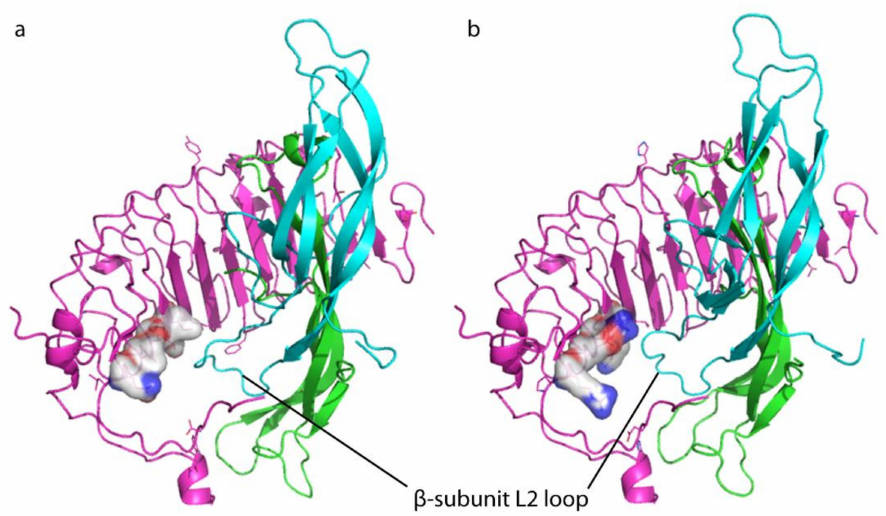
Figure 4. Comparison between mouse and human receptor extracellular leucine-rich-repeat domain (LRRD) bound to the heterodimeric hormone ( α and β subunit). ( a ) Images were obtained using hCG sequence as a template for the hormone, as previously described [3], and the α and β subunits are indicated with the colors green and light blue, respectively. Receptor LRRD is pink, while the murine and human LRR11 residue at positions 247, as well as the adjacent residues at position 225 and 270, are indicated by bubbles. mLhr LRRD- and ( b ) LHCGR LRRD-hCG complexes. The hormone β -L2 loop might potentially interact with these different, key residues of rodent and human